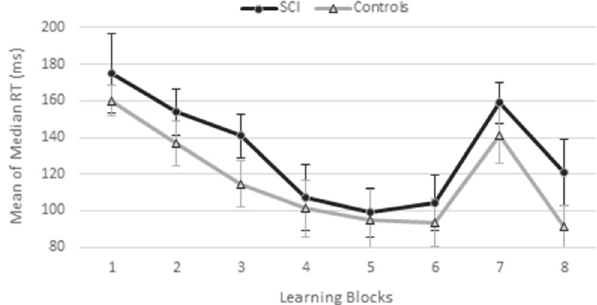
Fig 2. Ocular activated serial reaction time task reaction times (RT; mean and SEM) in the spinal cord injury (SCI) and control groups.